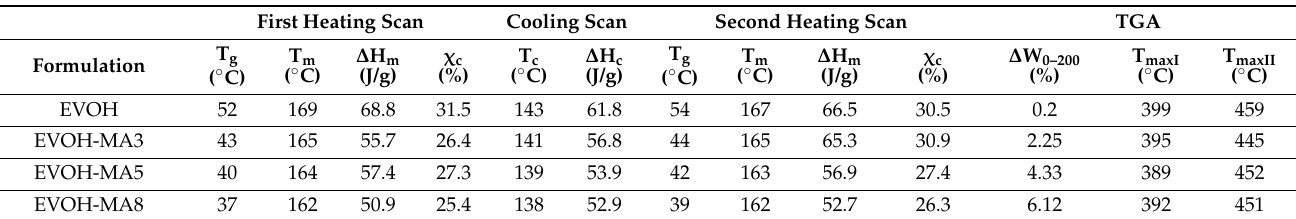
Figure 4. DSC thermograms during ( a ) first heating, ( b ) cooling and ( c ) second heating scan. Table 2. DSC and TGA